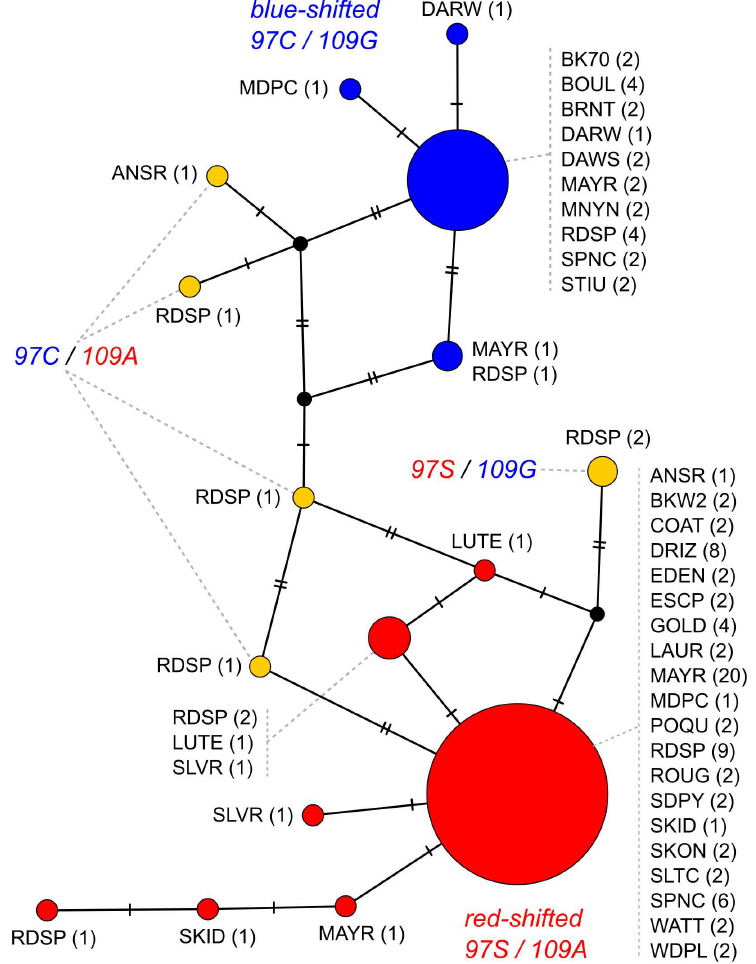
Fig 7. Median-joining network of SWS2 coding sequencehaplotypes. Virtually all populations across the HaidaGwaii adaptiveradiationrecruitedthe same red- or blue-shifted SWS2 allele.Population codesare shownin Table 1, numbers in brackets indicatethe numberof haplotypesamongall 58 sequencedindividuals, and the color codeindicateshaplotypespredictedto be red- or blue-shiftedor intermediate, basedon the two SWS2 opsinkey sites at position97 and